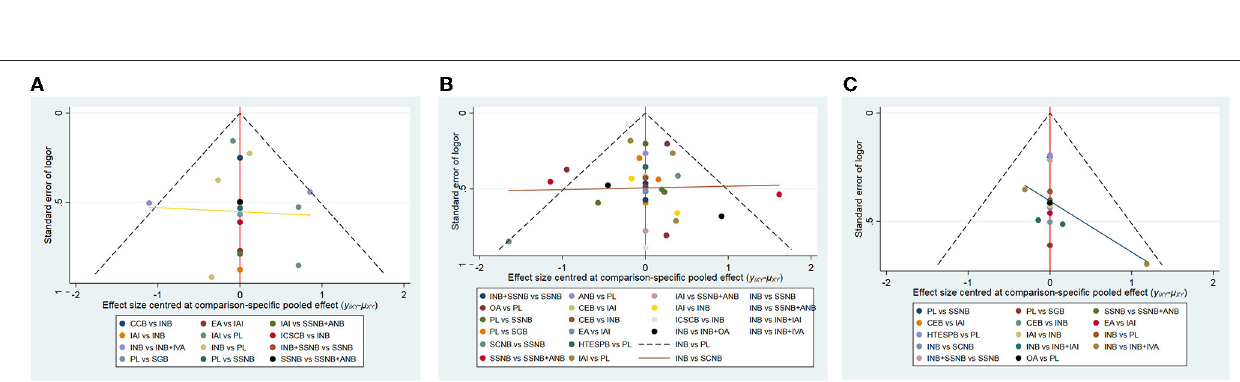
Frontiers in Medicine |